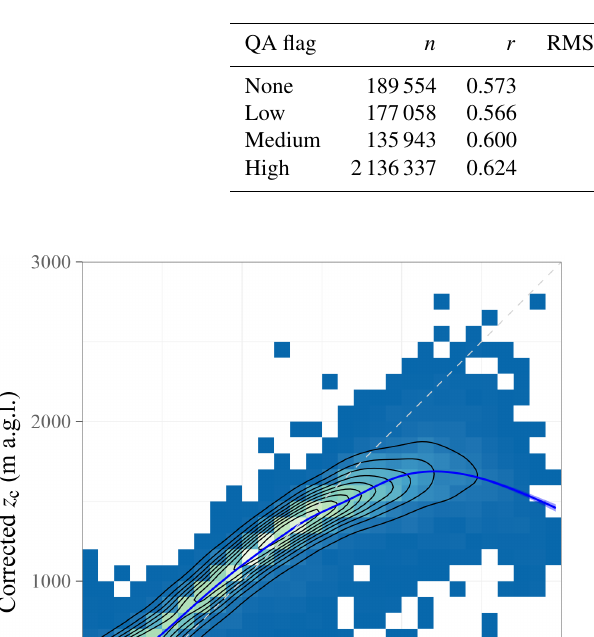
Figure 4. As in Fig. 3, but applying all requirements listed in Sect. 3.3. Table 3. As in Table 2, but applying all requirements listed in Sect. 3.3.